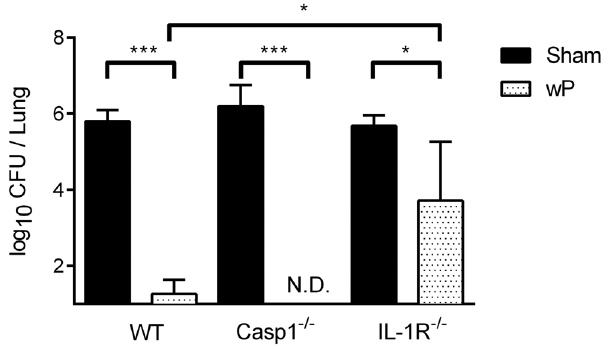
Figure 5. Adaptive immune responses are IL-1 dependent but Caspase-1 independent. Groups of four mice were either sham vaccinated with PBS or vaccinated with heat-killed B. pertussis (wP) by administering 200 m L i.p. at 28 and 14 days prior to challenge inoculation with 5 6 10 5 CFU. Lungs were excised at seven days post- challenge and to determine bacterial CFUs. Bar graphs represent the mean CFU per lung 6 standard deviation. Significance was determined by one-way ANOVA and Tukey’s multiple comparison post-hoc test with *p , 0.05, ***p , 0.001. Data is representative of two independent